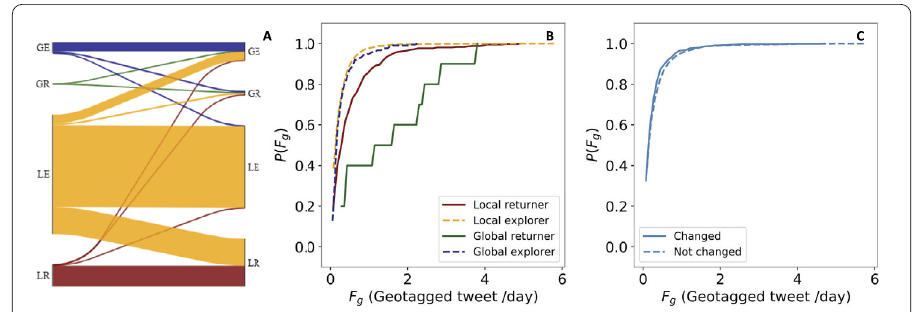
Figure 7 Reclassification results. ( A ) Group changes by the original groups. GE = Global explorer, GR = Global returner, LE = Local explorer, LR = Local returner. ( B ) Geotweeting frequency of four behavioural groups. ( C ) Geotweeting frequency of the users who are re-identified as the original group vs. the ones who are